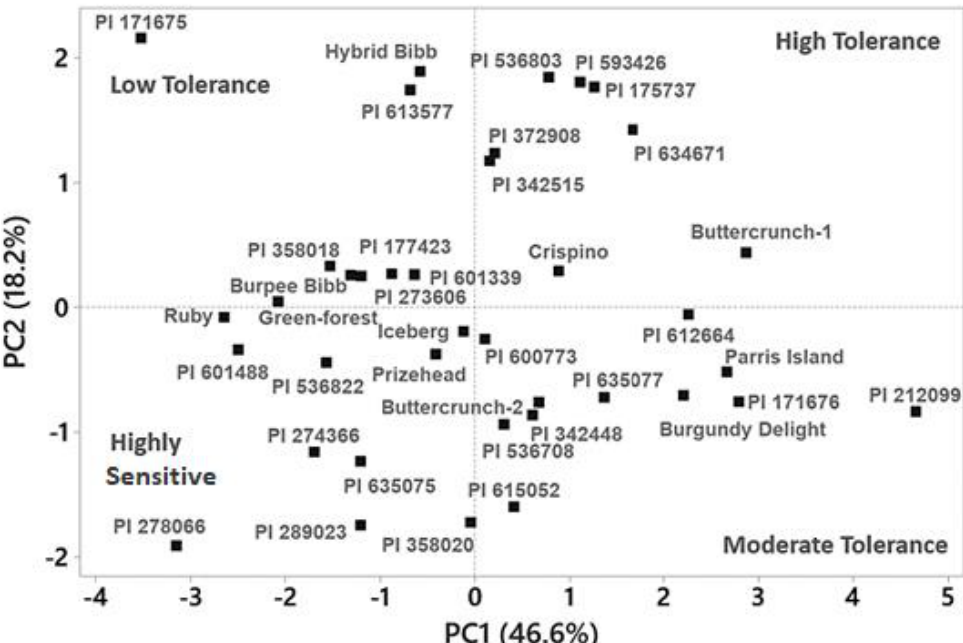
Figure 1. Principal component analysis (PCA) of first two principal components (PC) scores, PC1 and PC2 describing the classification of different lettuce genotypes into different salt-tolerant groups (high tolerance, moderate tolerance, low tolerance, and highly sensitive) based on seven morpho-physiological parameters measured 42 days after sowing for all the genotypes (10 days after salt treatment).